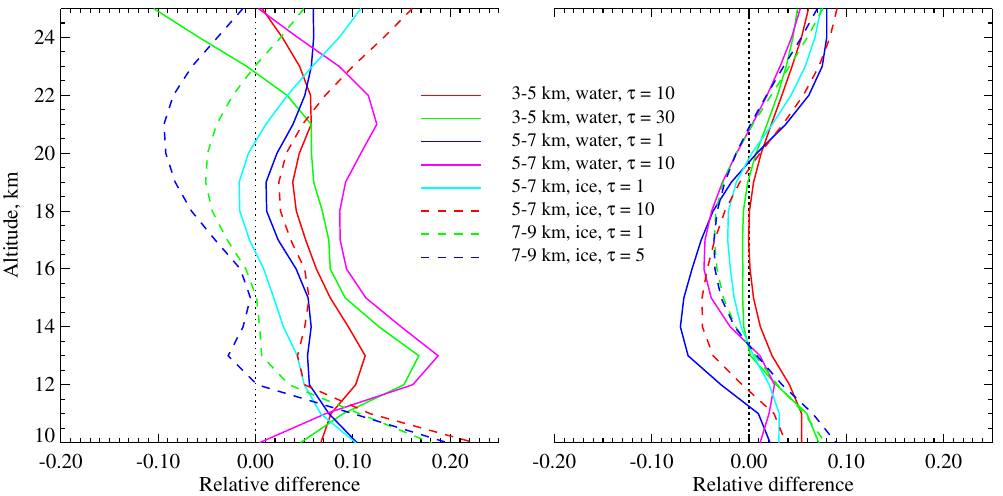
Fig. 11. Relative retrieval errors due to clouds for a tropical (left panel) and a high-latitude measurement (right panel) for water and ice clouds at different altitudes for different cloud optical thicknesses ( τ